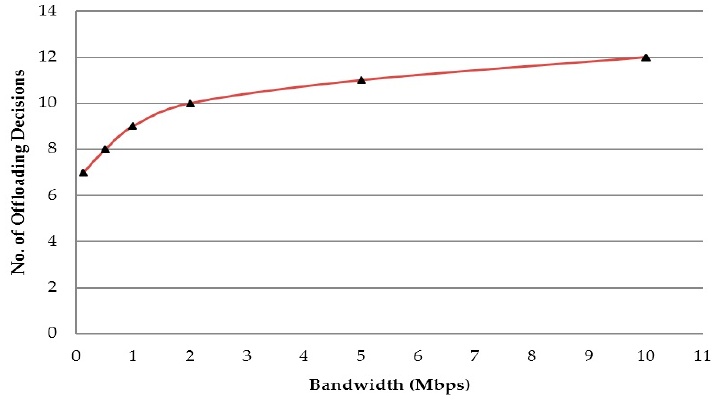
Figure 8. Impact of bandwidth change on offloading decisions (min: (cid:1846) (cid:3047)(cid:3042)(cid:3047)(cid:3028)(cid:3039) ).